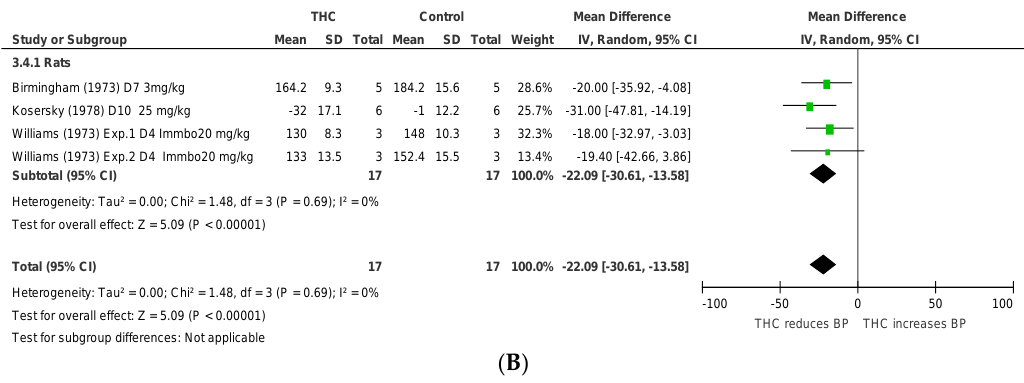
Figure 5. Changes in BP induced by ( A ) acute and ( B ) chronic THC dosing in animal models of stress or hypertension.